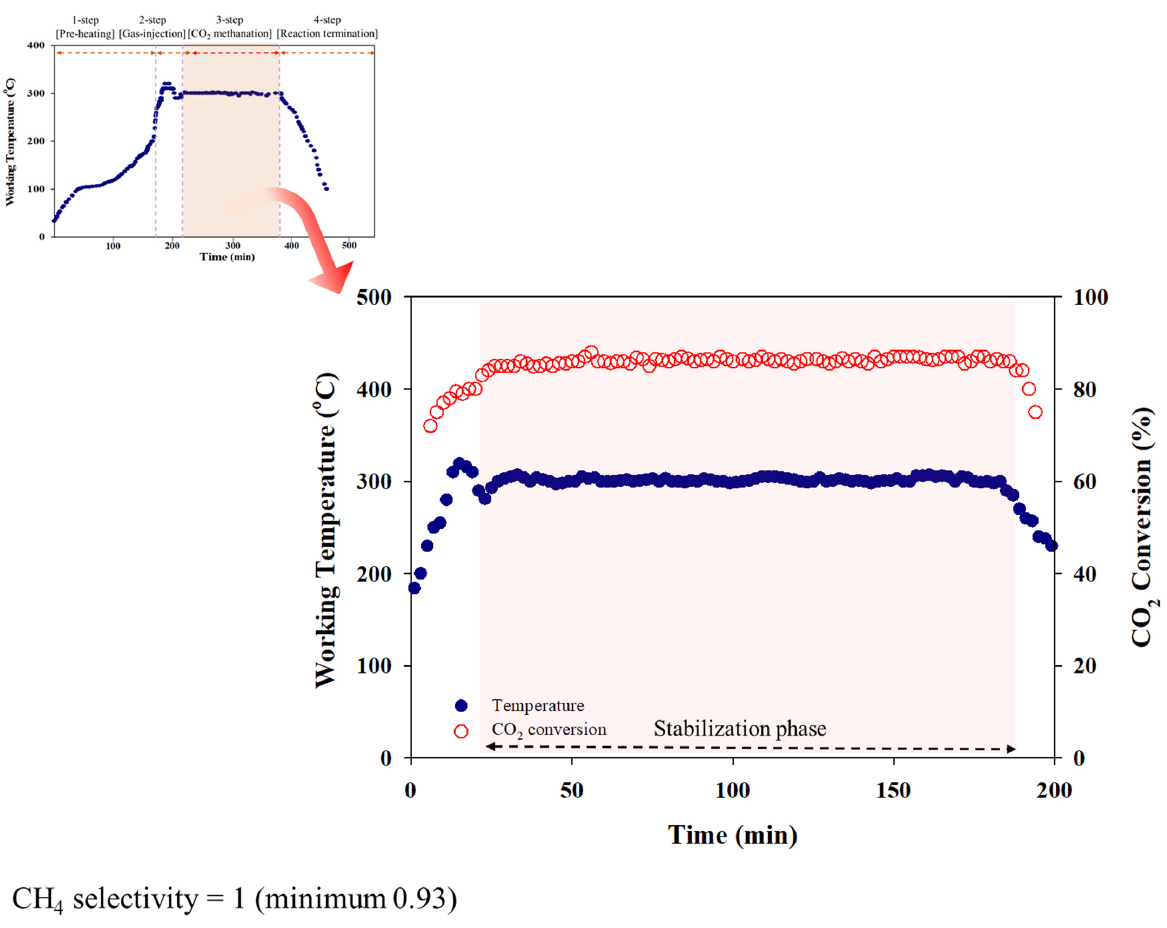
Figure 5. CO 2 methanation data in the pilot plant (inlet gas CO 2 :H 2 = 1:4, actual temperature 300 ± 5 °C).